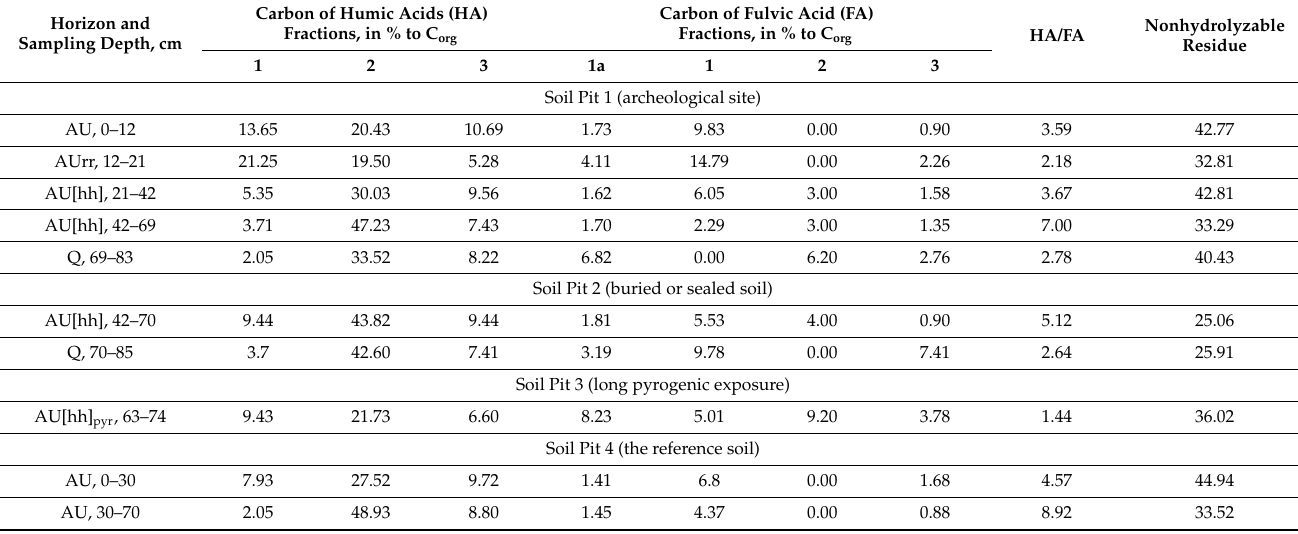
Table 2. Group and fractional composition of humus in the archeological site’s soil.